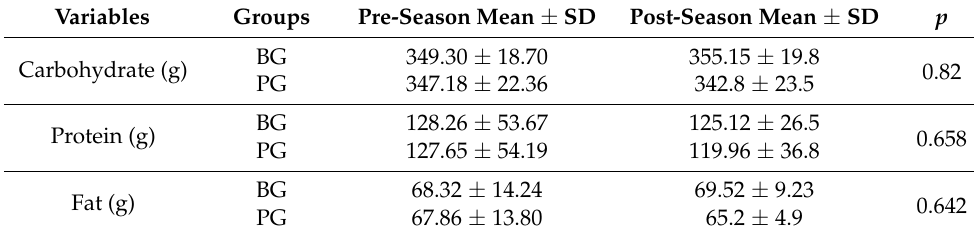
Table 1. The analysis of the average daily caloric and macronutrient intake. Variables Groups Pre-Season Mean ± SD Post-Season Mean ± SD p BG 349.30 ± 18.70 Carbohydrate (g) Protein